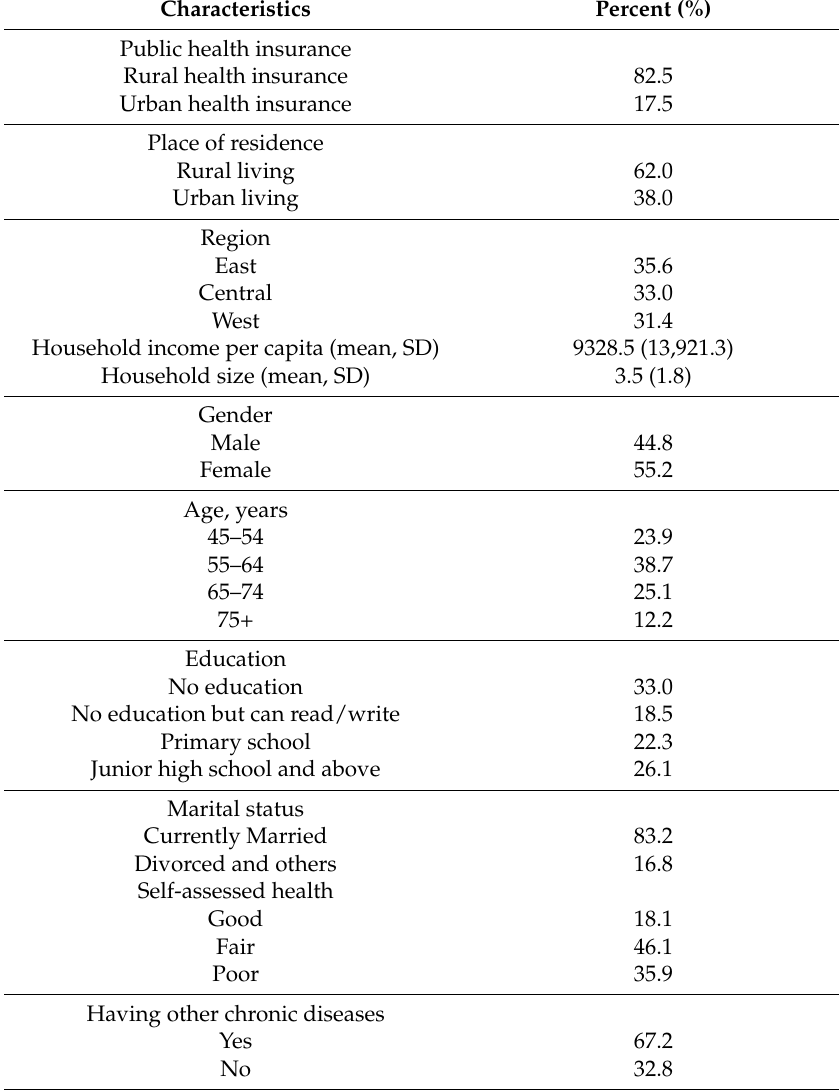
Table 2. Characteristics of the hypertensive respondents ( N =